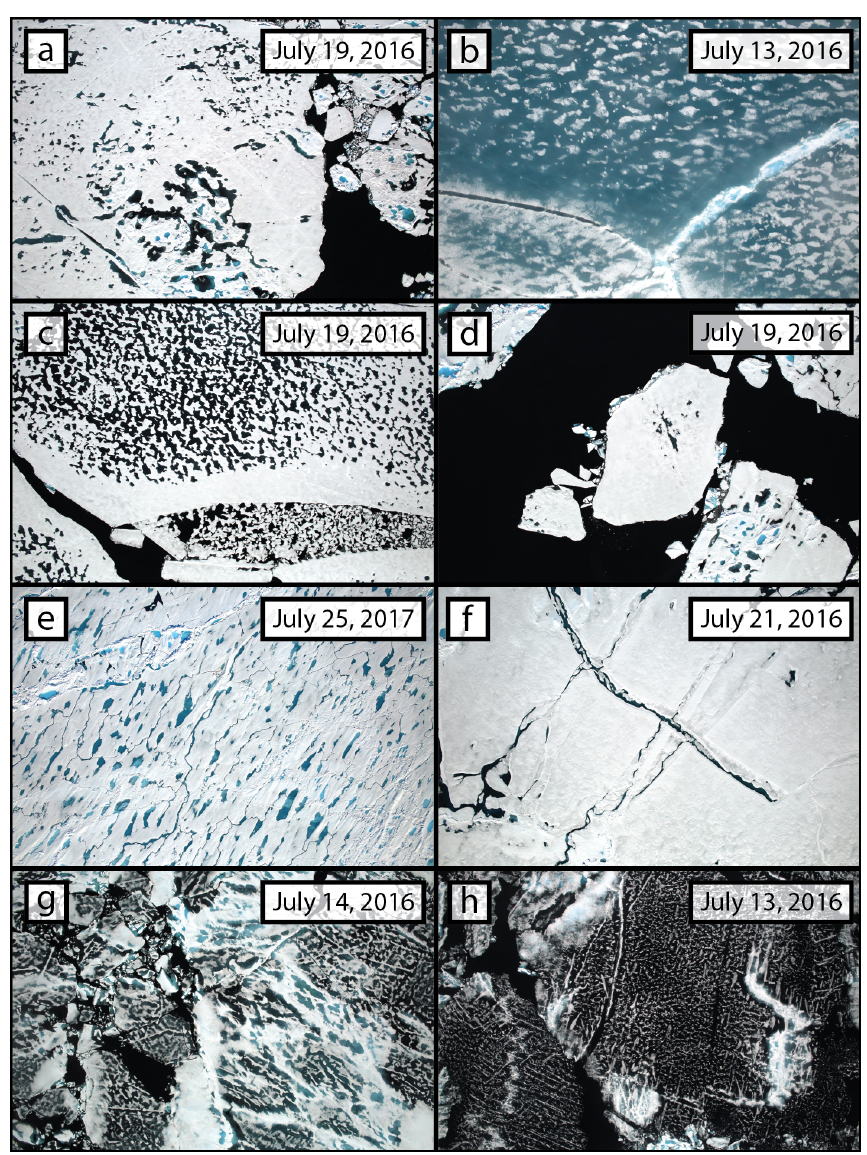
Figure 10. Exhibits of sea ice surface features as seen in the DMS dataset. Each panel is a full IceBridge image, and while flight altitude affects image resolution and footprint, each scene is approximately 600m by 400m. See text for full description of each